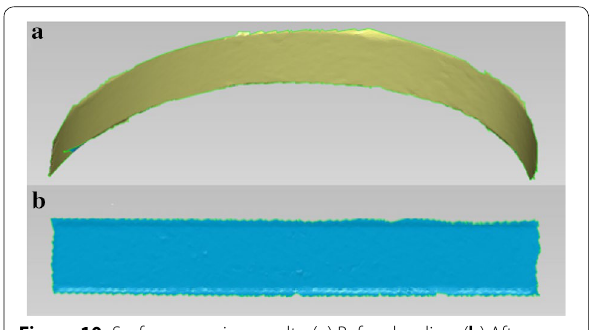
Figure 10 Surface scanning results: ( a ) Before leveling; ( b ) After leveling